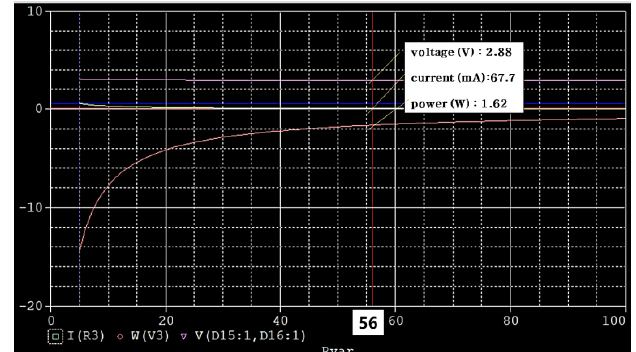
Figure 20. Plant growing LED performance. Table 3. Photosynthetic photon flux density (PPFD) measurement results.